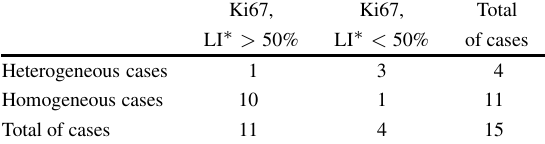
Ploidy pattern and proliferative activity